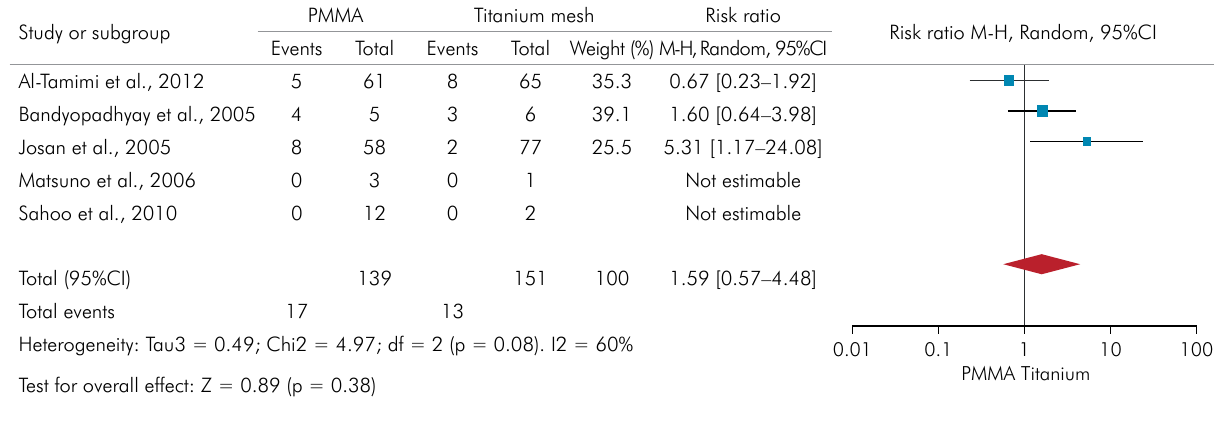
Figure 3. Forest plot: comparison between PMMA and titanium with respect to